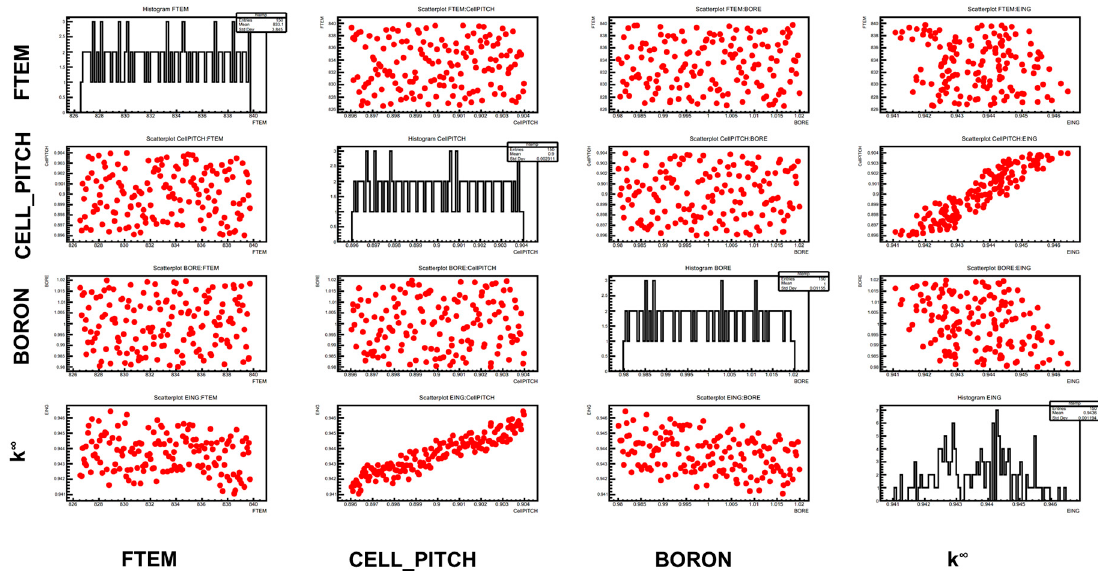
Energies 2022 , 15 , x FOR PEER REVIEW 18 of 31 Figure 15. Hexagonal UOX CELL: Pairs plot (FTEM, CELL_PITCH, BORON). Figure 15. Hexagonal UOX CELL: Pairs plot (FTEM, CELL_PITCH, BORON).